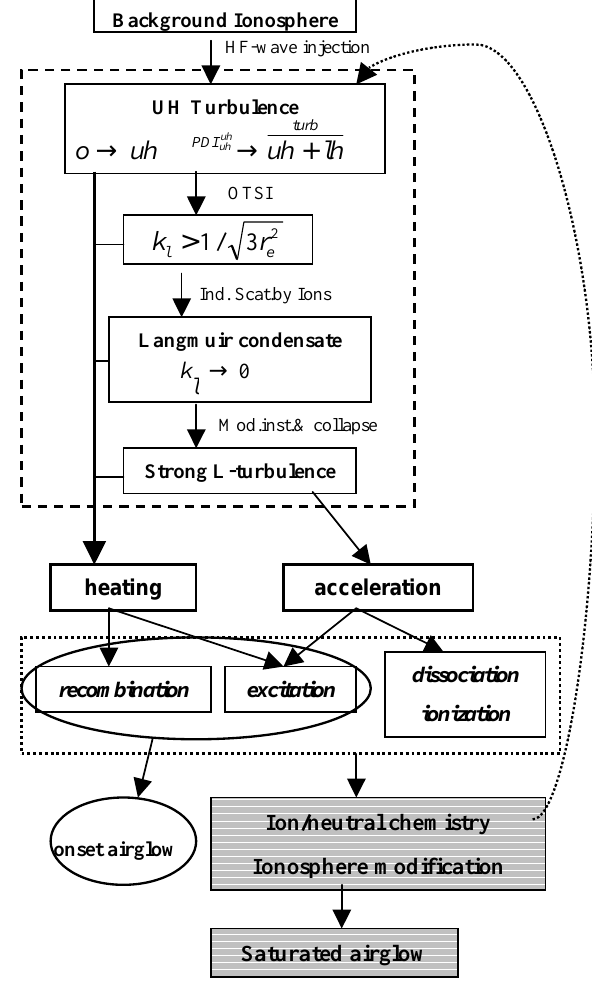
Fig. 2. Block-diagram from Mishin et al. (2004) showing energy flow in a model of HF-induced airglow at MZ. Shaded boxes indi- cate the steps to be worked